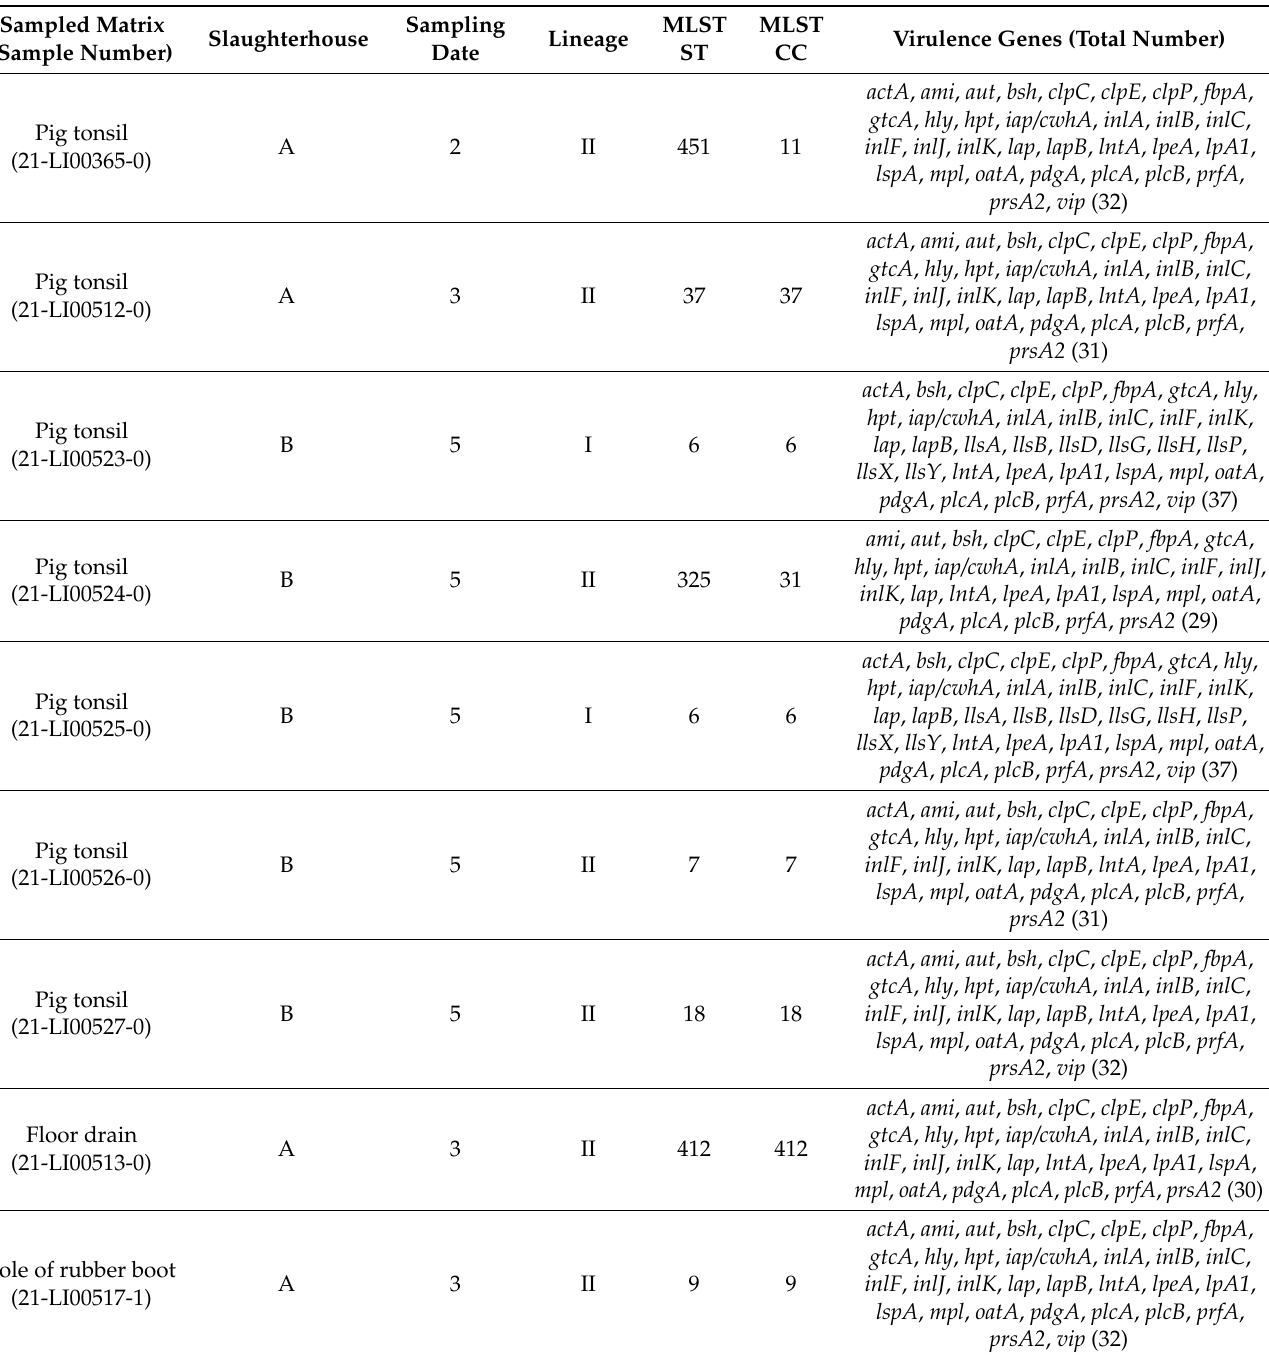
Table 2. Characteristics of L. monocytogenes isolates found in pigs and in the environment 1